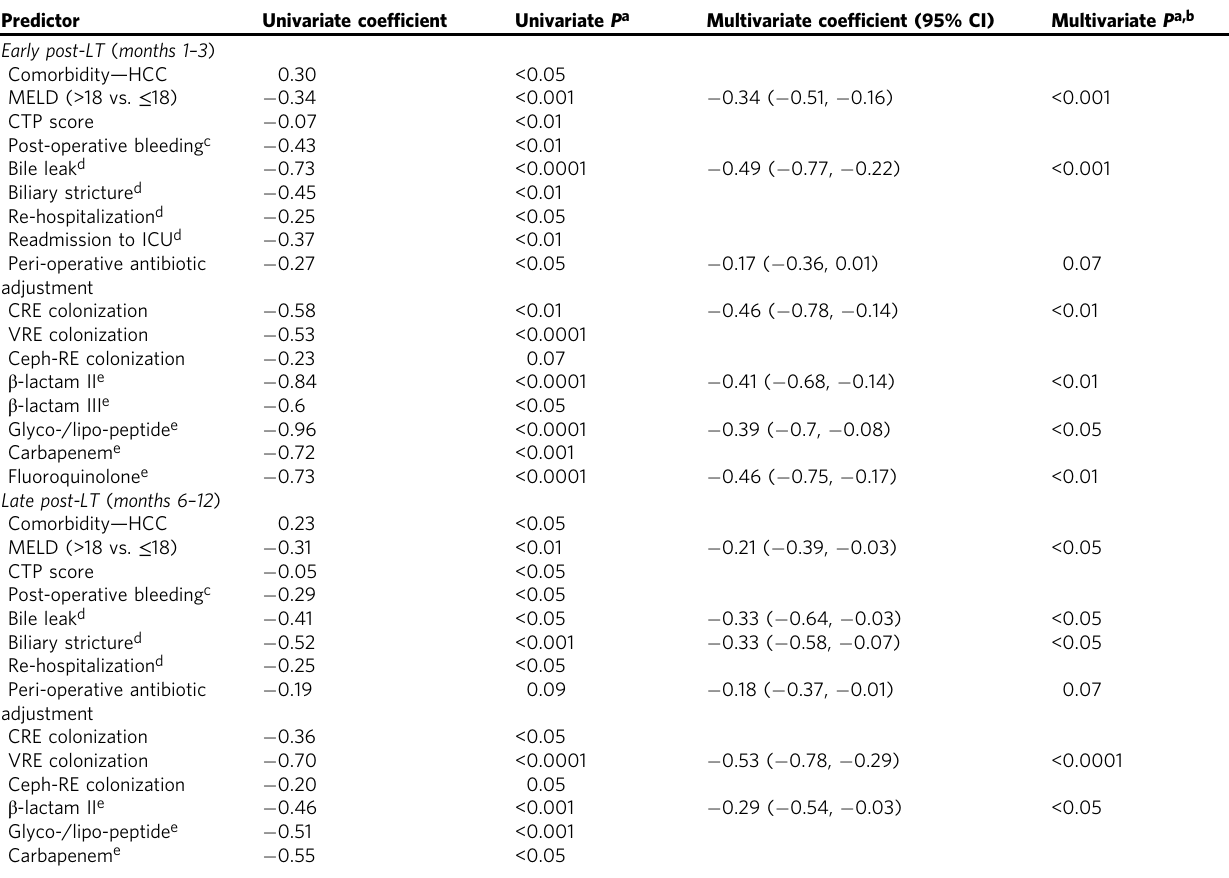
Table 3 Multivariate linear mixed-effect regression models assessing clinical and microbial predictors associated with gut microbiome α -diversity after liver